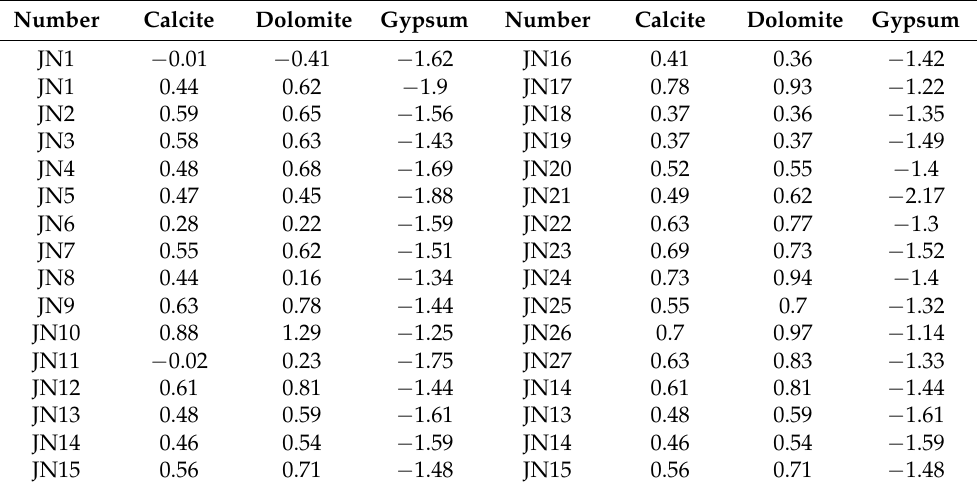
Table 3. Mineral saturation index table of karst water sampling points on runoff